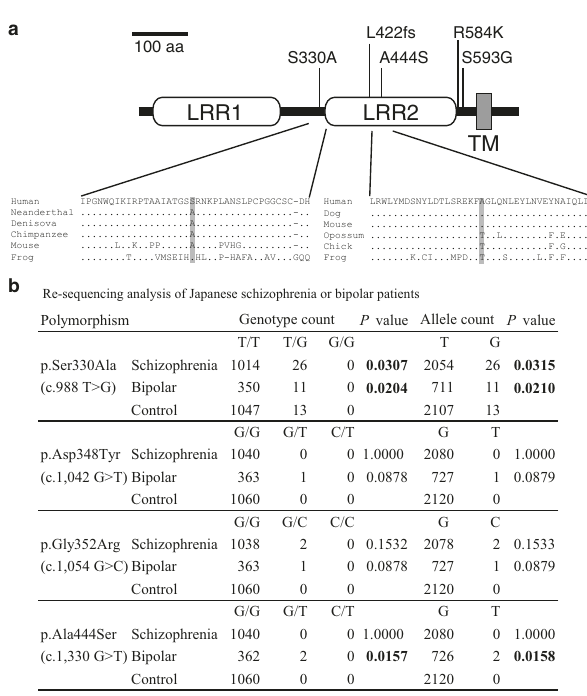
Fig. 7 Screening of SLITRK1 missense mutations in patients with a neuropsychiatric disorder. a The domain structure of human SLITRK1 and patient-derived missense mutations. S330A (BPD/SCZ, this study), A444S (BPD, this study), L422fs (Tourette ’ s syndrome) 1 , R584K/S593G (Trichotillomania) 5 . aa amino acid, LRR leucine-rich repeat, TM transmembrane domain. b Results of resequencing analysis of Japanese patients with SCZ and BPD. P values indicate those obtained in χ 2